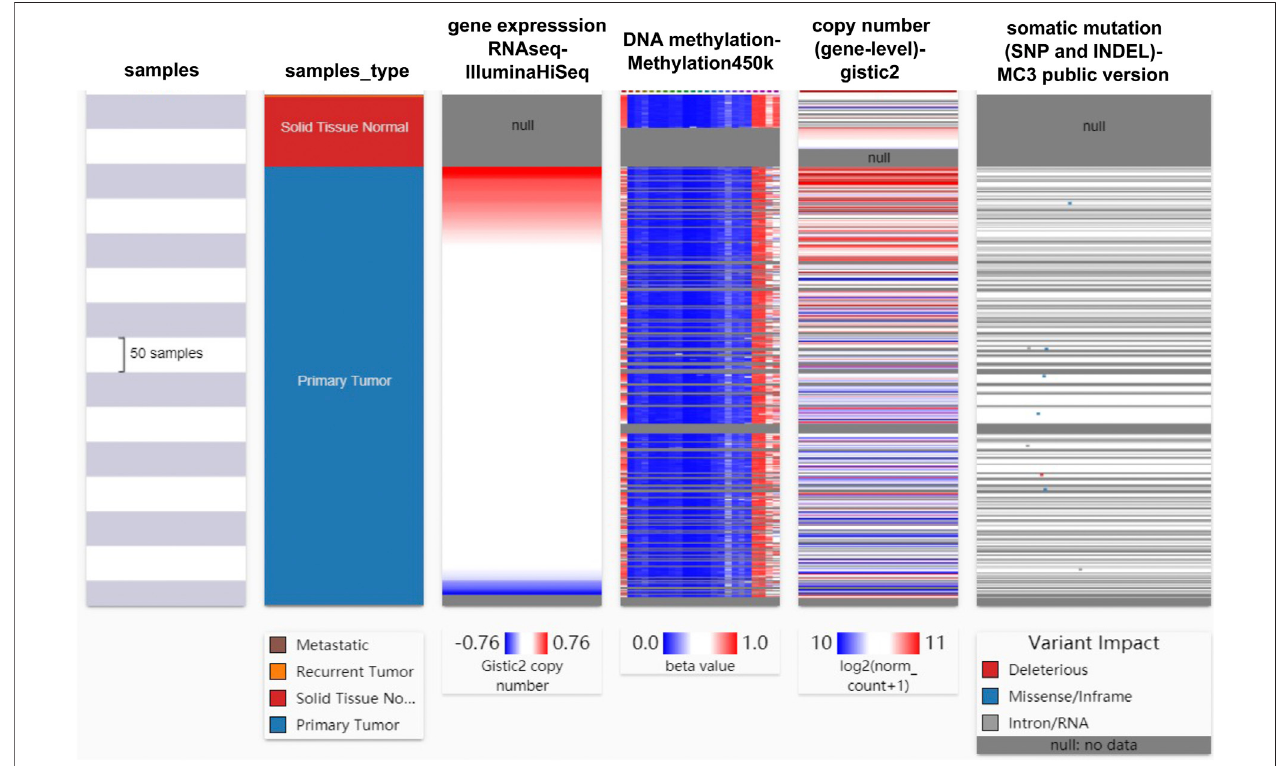
FIGURE 4 | Heat map of Mapk14 mRNA expression, methylation, copy number and somatic mutations in CRC patients and normal tissues. Data are from the TCGA-COAD-READ and include 736 samples in total.